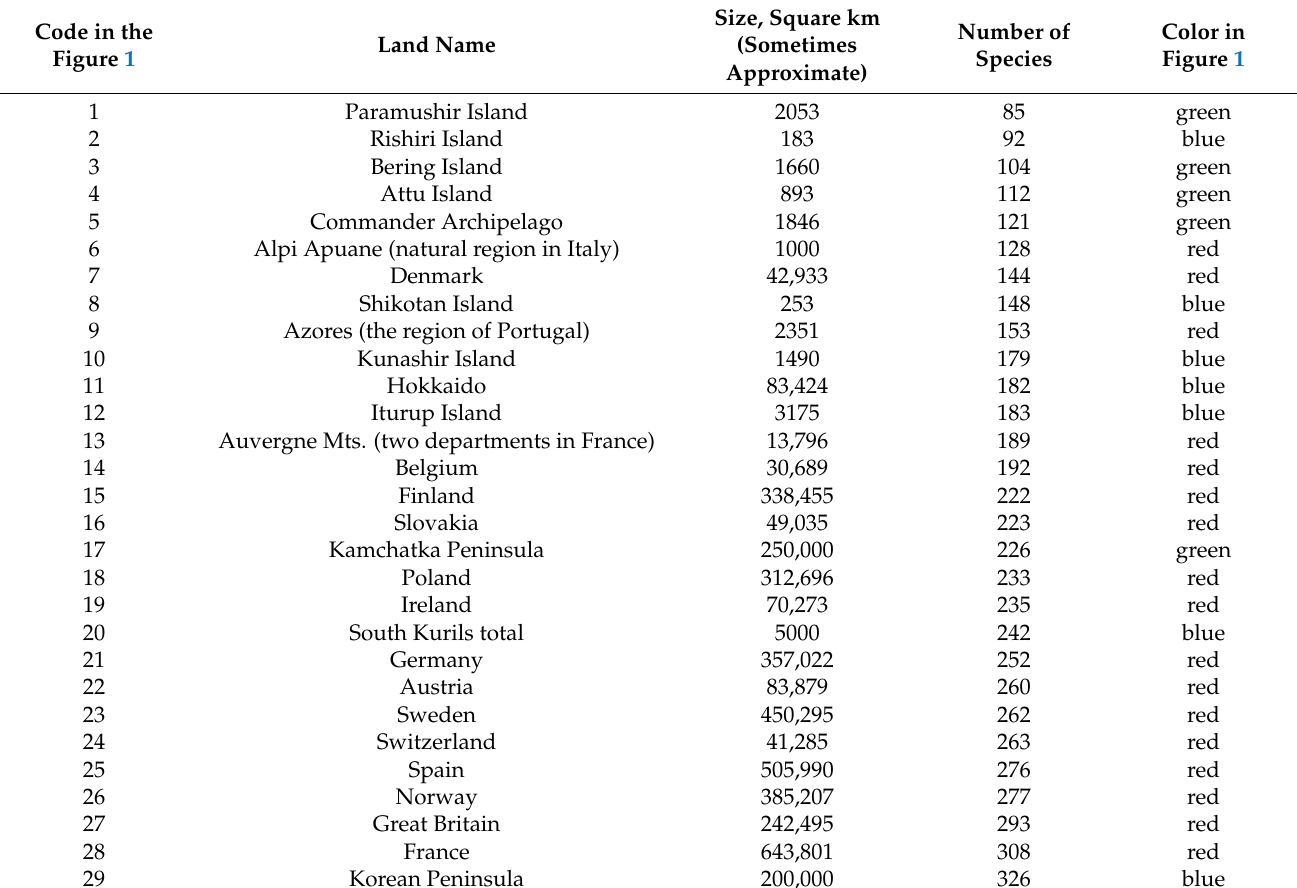
Table 1. The data on taxonomic diversity and area size in selected floras used for graphic diagram presented in Figure 1. The data on diversity are from [36–38,41–44] and the present paper. The data on the area are from https://en.wikipedia.org/wiki/Main_Page, (accessed on 19 August